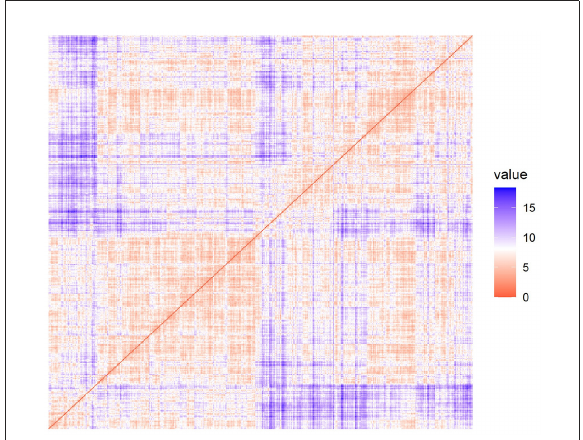
FIGURE3 Ordered dissimilarity image for cluster tendency analysis.